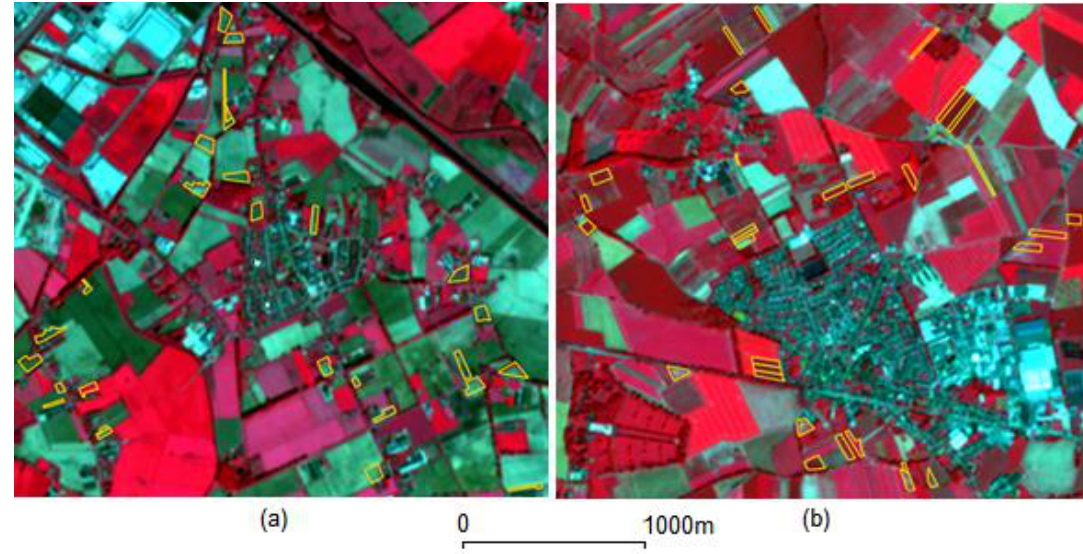
Figure 2. Magnified detail showing crop parcels (fields) within an area of interest (AOI): ( a ) example of AOI_1 in the background Sentinel-2 image from 06 / 05 / 2018; ( b ) example of AOI_2, in the background Sentinel-2 image from 27 / 06 / 2018. Sentinel-2 images are illustrated in false-color composite (R: near-infrared (NIR), G: red, B: green).